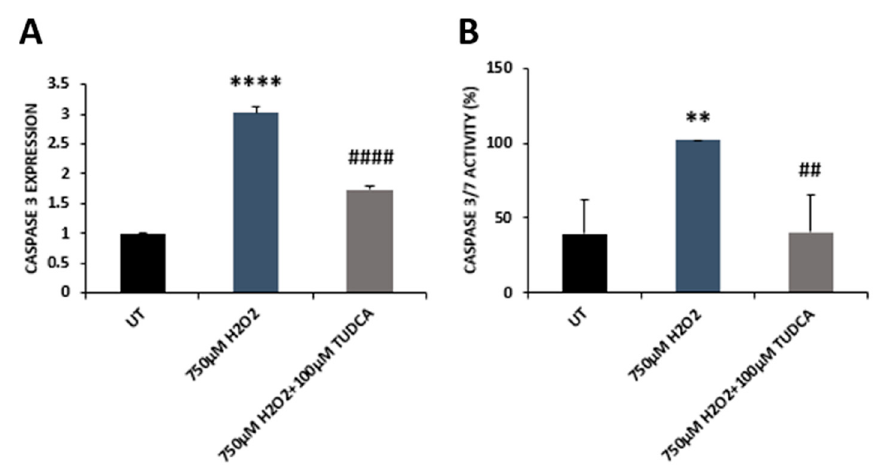
Figure 2. TUDCA decreases oxidative stress-induced caspase 3 expression and caspase 3/7 activity in ARPE-19 cells. ( A ) Caspase 3 mRNA in control (UT), H 2 O 2 , and H 2 O 2 -plus-TUDCA-treated cells were measured by qRT-PCR. ( B ) Activities of caspase 3 and 7 in control (UT), H 2 O 2, and H 2 O 2 -plus-TUDCA-treated cells were measured using CASPASE-Glo 3/7 assay. Data were presented as mean ± SEM. ** p < 0.01 and **** p < 0.0001, 750 µM H 2 O 2 vs. untreated (UT) control; ## p < 0.01, #### p < 0.0001, 750 µM H 2 O 2 plus TUDCA vs. 750 µM H 2 O 2 .